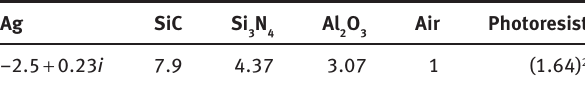
Table 1: Material